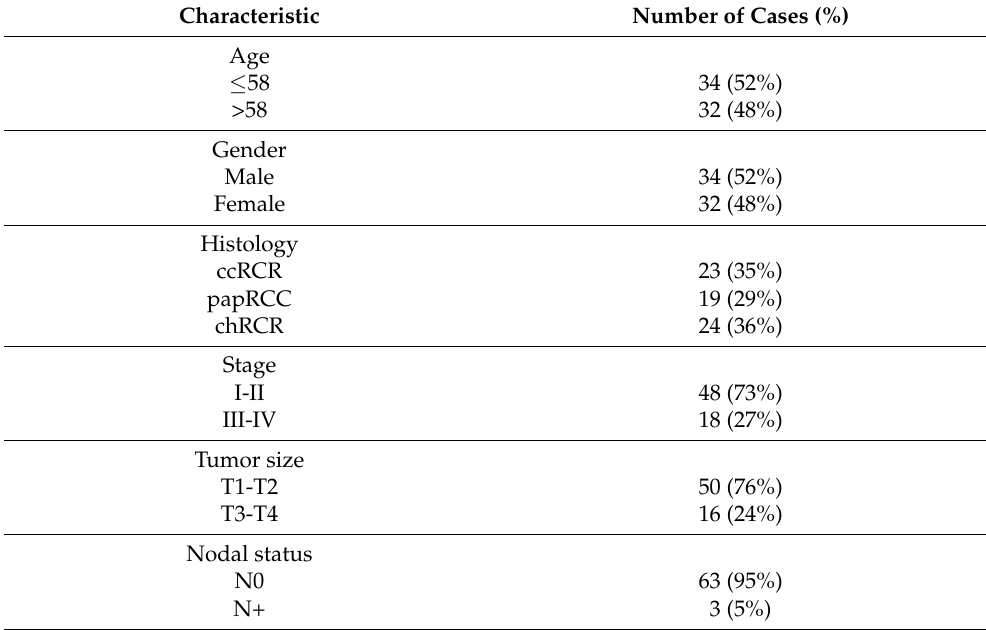
Table 1. Clinical and morphological characteristics of RCC